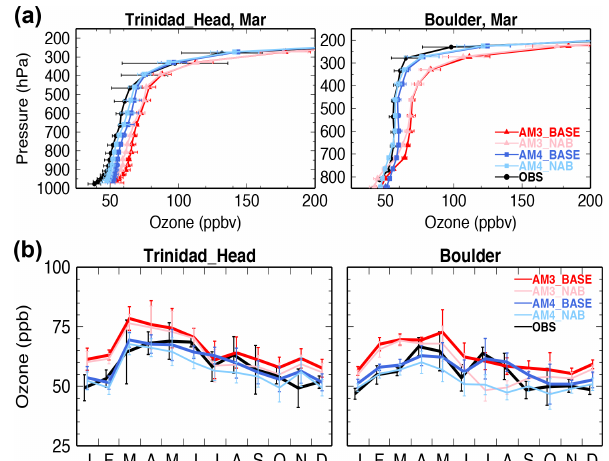
Figure 2. (a) Vertical profiles of O 3 in March and (b) monthly mean O 3 in the middle troposphere (500–430hPa) at Trinidad Head, California (41.1 ◦ N, 124.2 ◦ W; 107ma.s.l.) and Boulder, Colorado (40.0 ◦ N, 105.0 ◦ W; 1584ma.s.l.) during 2010–2014 as observed (black) and simulated by GFDL-AM3 (red; AM3_BASE; Lin et al., 2017) and GFDL-AM4 (blue; AM4_BASE), together with simu- lated North American background O 3 (NAB; estimated with North American anthropogenic emissions zeroed out). The bars represent the standard deviations of monthly values during